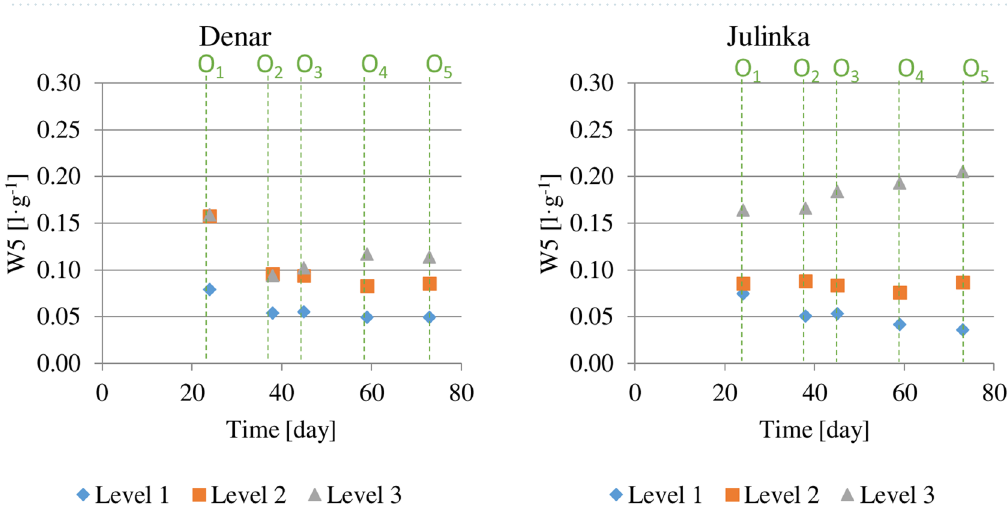
Figure 8. Ratio of average daily water consumption to average daily tuber mass increase dependent on three soil humidity levels (1), (2), (3), in each of five potato growing stages (O1), (O2), (O3), (O4), (O5).